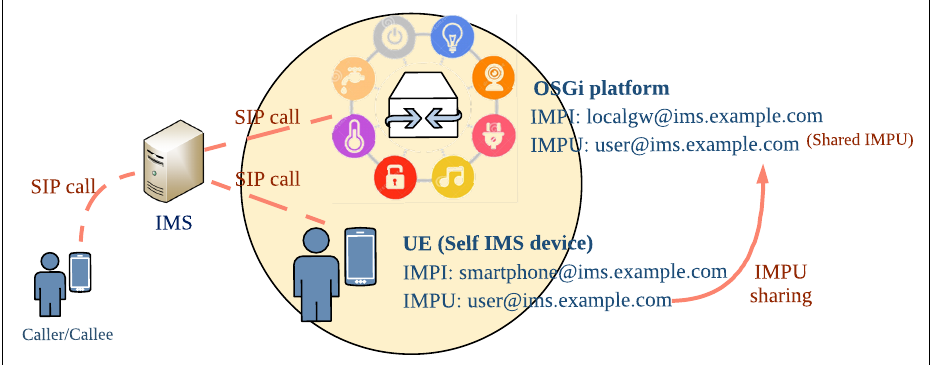
Figure 2. System